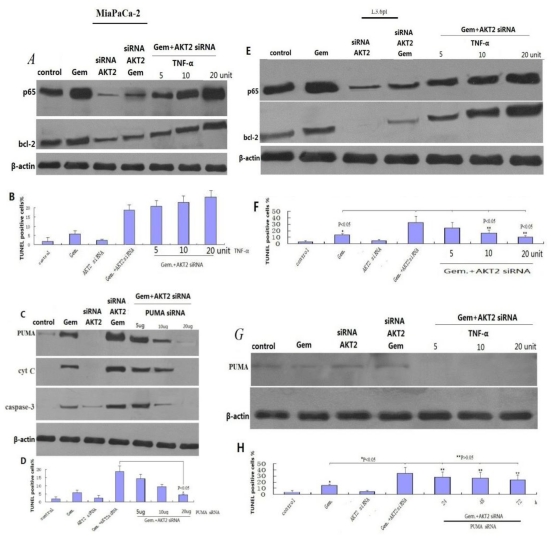
In vitro mechanism of action of gemcitabine alone and in combination with AKT2 inhibition. (A,E) L3.6pl and MiaPaCa-2 cells were treated with gemcitabine (0.1, 0.5 or 1 μM), combination of gemcitabine and AKT2 siRNA (100 MOI), or TNF-α (5–20 U). Western blotting was used to detect NF-κBp65 and Bcl-2; (C,G) L3.6pl and MiaPaCa-2 cells were treated with gemcitabine (0.1, 0.5 or 1 μM), combination of gemcitabine and AKT2 siRNA (100 MOI), or PUMA siRNA (20 μg). Western blotting was used to detect PUMA and its downstream gene; (B,F,D,H) TUNEL method was used to detect apoptosis in the above cells.